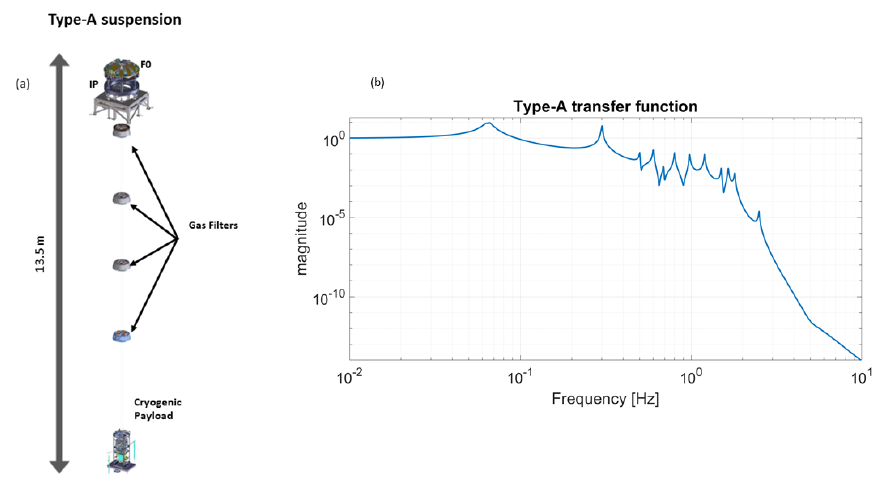
Figure 8. Panel ( a ) shows a technical drawing of a Type A system. From top to bottom, the isolation stages are: the pre-isolator (inverted pendulum and top filter—F0), four GAS filters, and the cryogenic payload (platform, intermediate-mass, marionette, and mirror) [23]. Panel ( b ) shows the Type A mechanical transfer function from the ground to the test mass along the longitudinal degree of